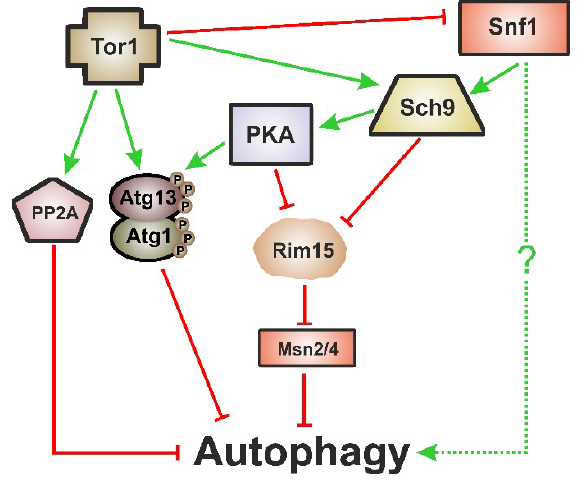
FIGURE 2: Autophagy regulation by nutrient-sensing pathways. Tor1 is the main negative regulator of autophagy. Tor1 can direct- ly exert its negative regulation through phosphorylation of Atg13 and Atg1 or through its downstream target, PP2A (ser- ine/threonine protein phosphatase 2A), a negative regulator of autophagy. Atg1 and Atg13 could also be phosphorylated by PKA, at residues distinct from those targeted by Tor1. PKA and Sch9 pathways are also negative regulators of autophagy. Apparently, TOR and PKA pathways operate in parallel, whereas Sch9 acts in parallel with PKA and partially dependent on TOR. Regulation of autophagy by Sch9 and PKA can be mediated by the inhibition of Rim15 and the Msn2/4 transcription factors. Tor1 is also able to inhibit the activity of the metabolic sensor Snf1, which is a posi- tive regulator of autophagy by still unknown mechanisms. Green arrows indicate interactions that induce autophagy, red bars indi- cate inhibition. See the text for